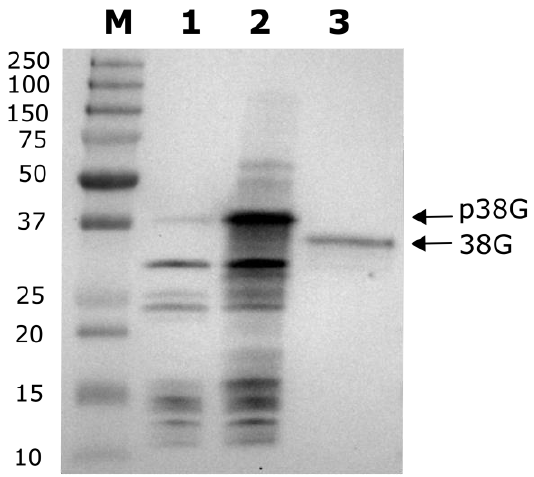
Figure 5. Comparison of the apparent molecular mass of the LEA38-GFP precursor and the mature LEA38-GFP. Precursors for LEA2-GFP and LEA38-GFP were synthesized in vitro. The mature LEA38-GFP (38G) was immunopurified from the leaves of an Arabidopsis overexpressor. Proteins were analyzed by Western blot using the anti-LEA38 antibody. This antibody was very specific to LEA38 and did not cross-react significantly with LEA2. 1, in vitro synthesized LEA2-GFP precursor (above 37 kDa); 2, in vitro synthesized LEA38-GFP precursor; 3, immunopurified mature LEA38-GFP. Arrows indicate the LEA38-GFP precursor (p38G) and mature LEA38-GFP (38G); M: molecular mass markers, with mass indicated in kDa.